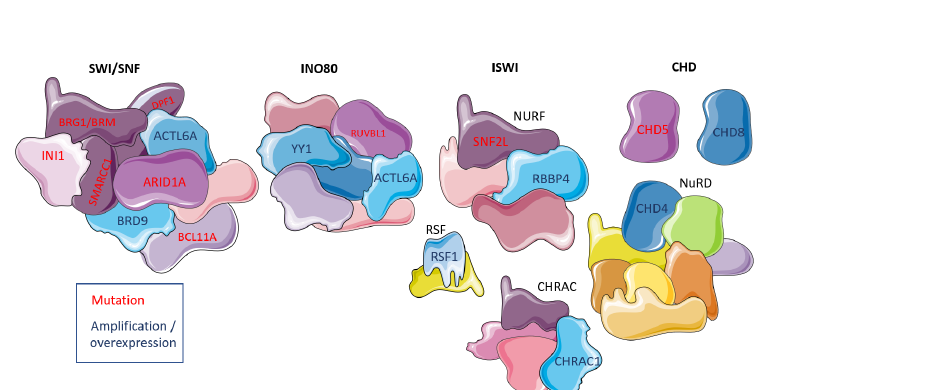
Figure 2. Chromatin remodeling complexes and their involvement in ovarian cancer. Deregulated domains are shown in either purple with red text denoting mutations in coding genes or blue with dark blue text denoting expression up-regulation. The figure was generated using Servier